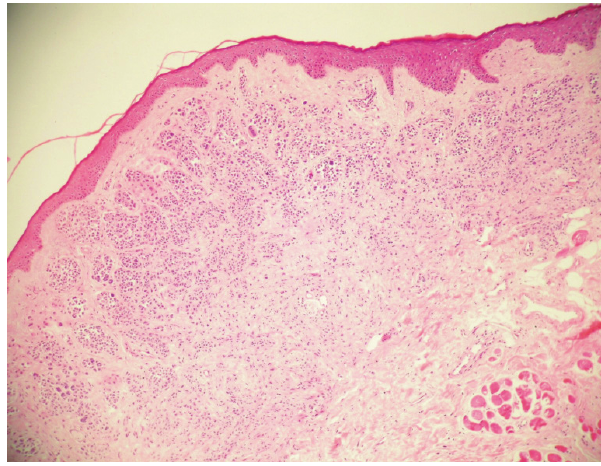
Figure 1 - Photomicrography on H/E - 100x – where the organization of nests can be seen more superficially and, more deeply in the conjunctive tissue, the spread of nevoid